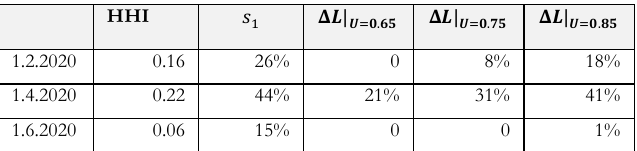
Table 1 . Calculation of L&E